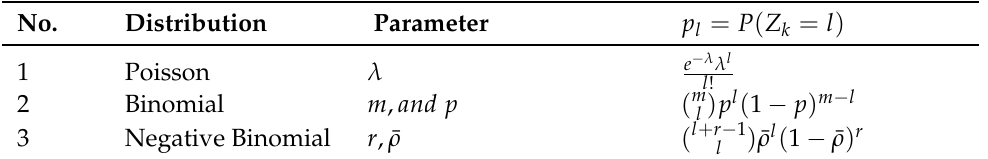
Table 3. Distribution of Z k